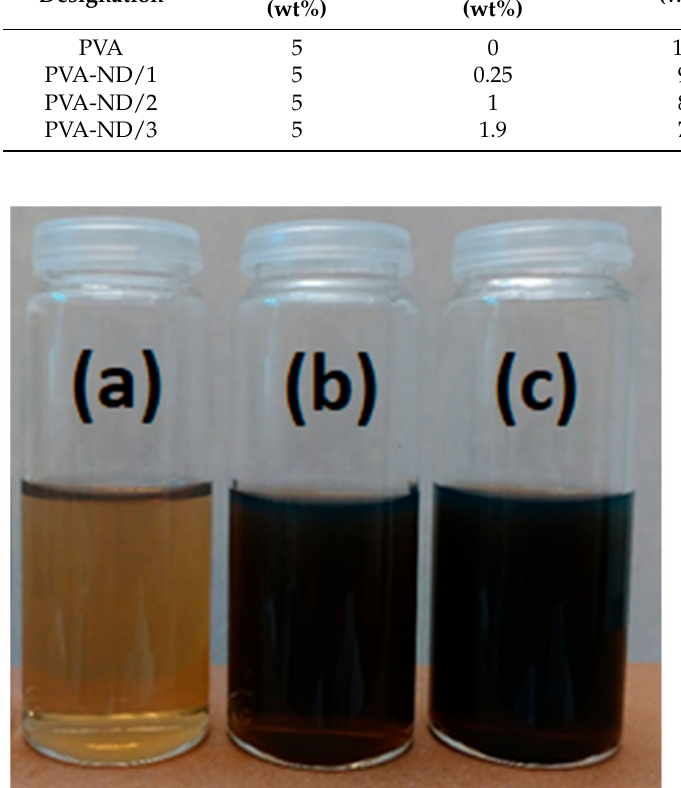
Figure 1. Visual comparison of the ND dispersions at the three weight concentrations, ( a ) 0.25, ( b ) 1, and ( c ) 1.9 wt% in DI